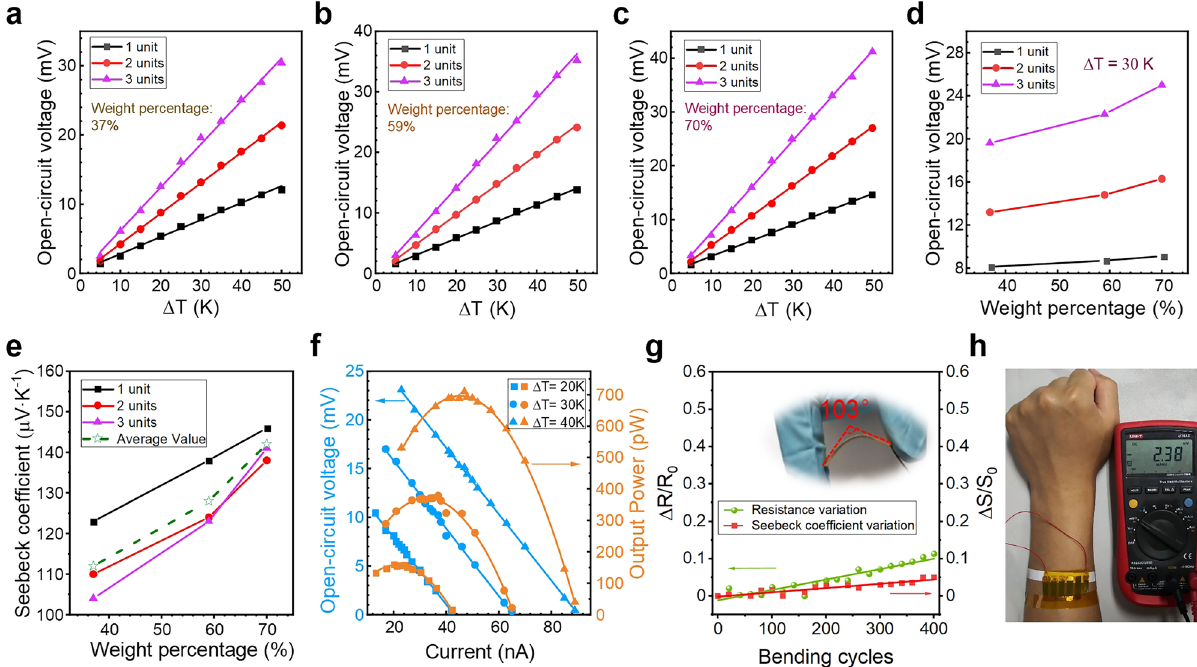
Fig. 3 TE performance tests of the PTGs. a – c Open-circuit voltage of the PTGs prepared by modi fi ed paper 37 ( a ), modi fi ed paper 59 ( b ), and modi fi ed paper 70 ( c ) at temperature differences of 5 to 50 K. d Open-circuit voltage of the PTGs versus the three weight percentages at a temperature difference of 30 K. e Seebeck coef fi cients (absolute value) of a single leg of the PTGs at the three weight percentages. f Output voltage and output power curves according to the various external circuit currents. g Changes in the resistance and Seebeck coef fi cient after 400 bending cycles. The insert is the schematic diagram of the bending test. h Photograph of human skin generating electricity with the PTGs.